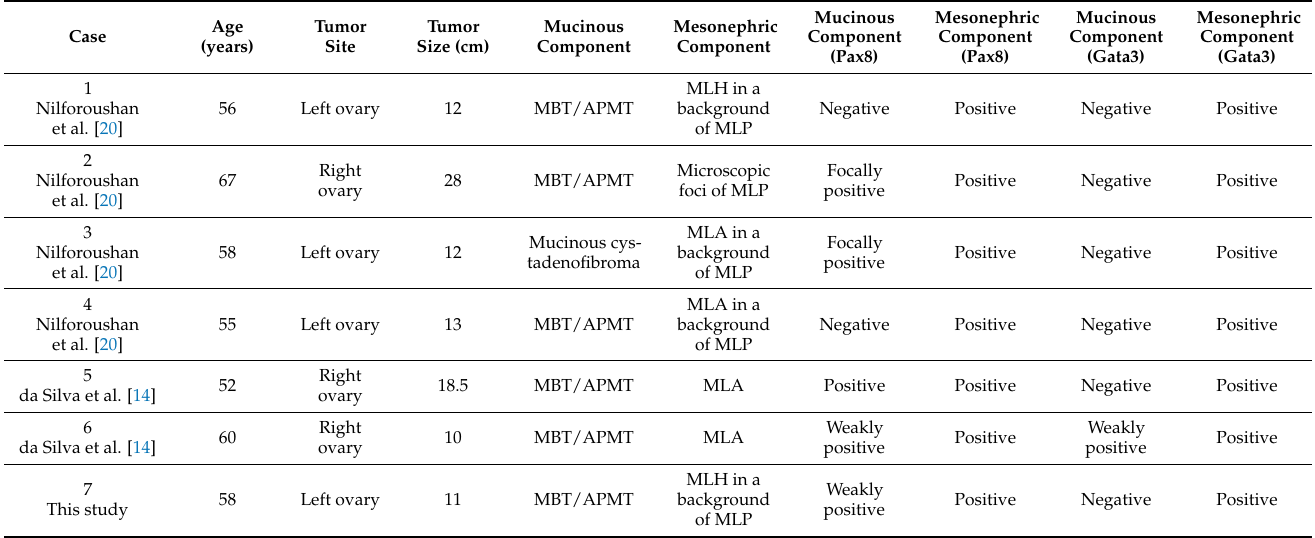
Table 1. Clinicopathological features and selected immunohistochemical